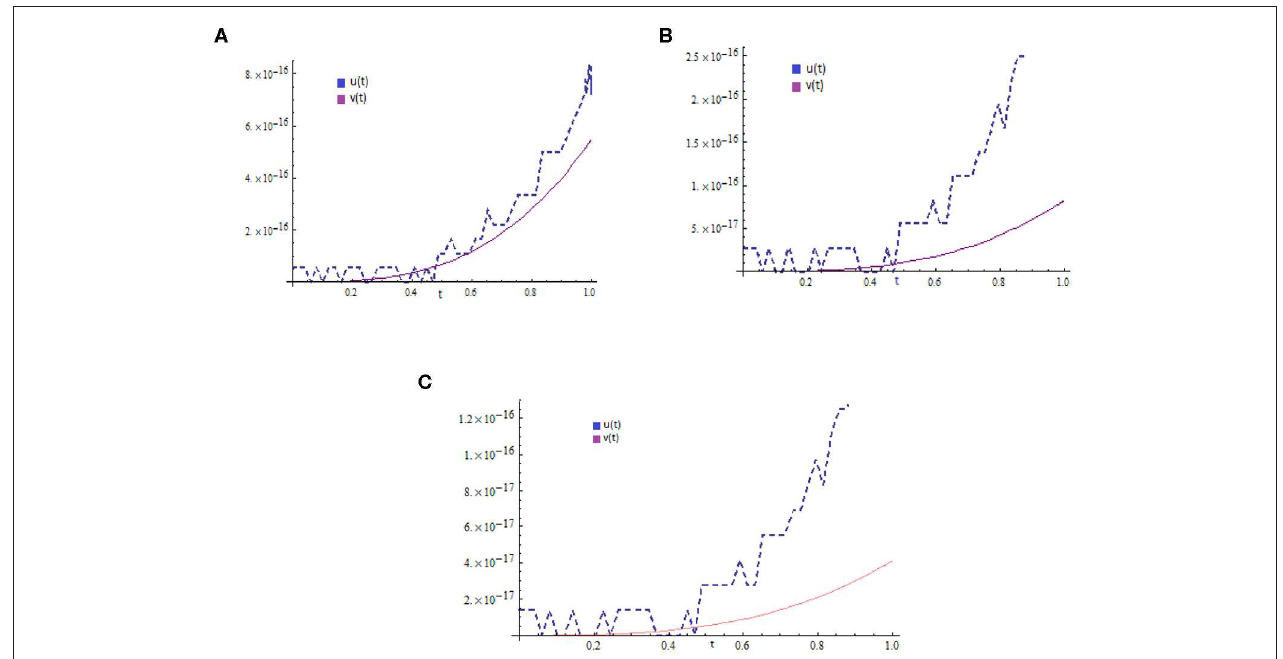
FIGURE 4 | Absolute error curves for coupled (A) WBK equation, (B) MB equation, (C) ALW equation at x